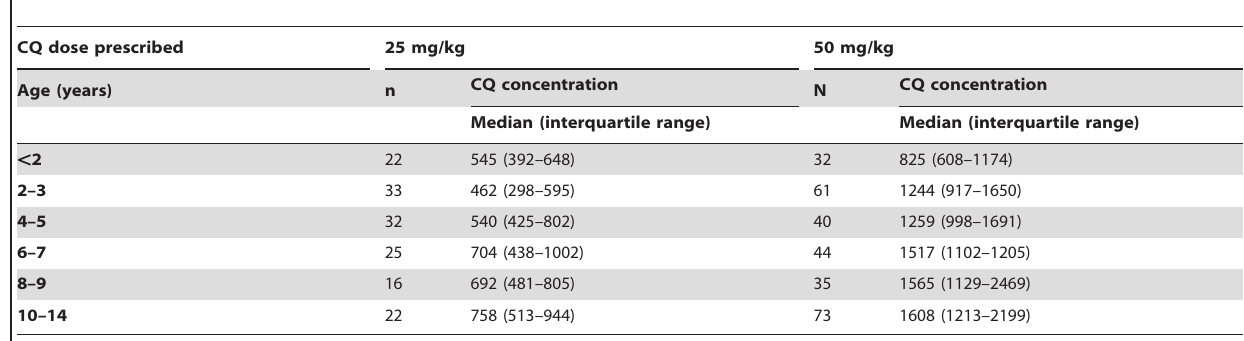
Table 2. Median and interquartile range chloroquine concentrations (nmol/l) in different age groups. CQ dose prescribed 25